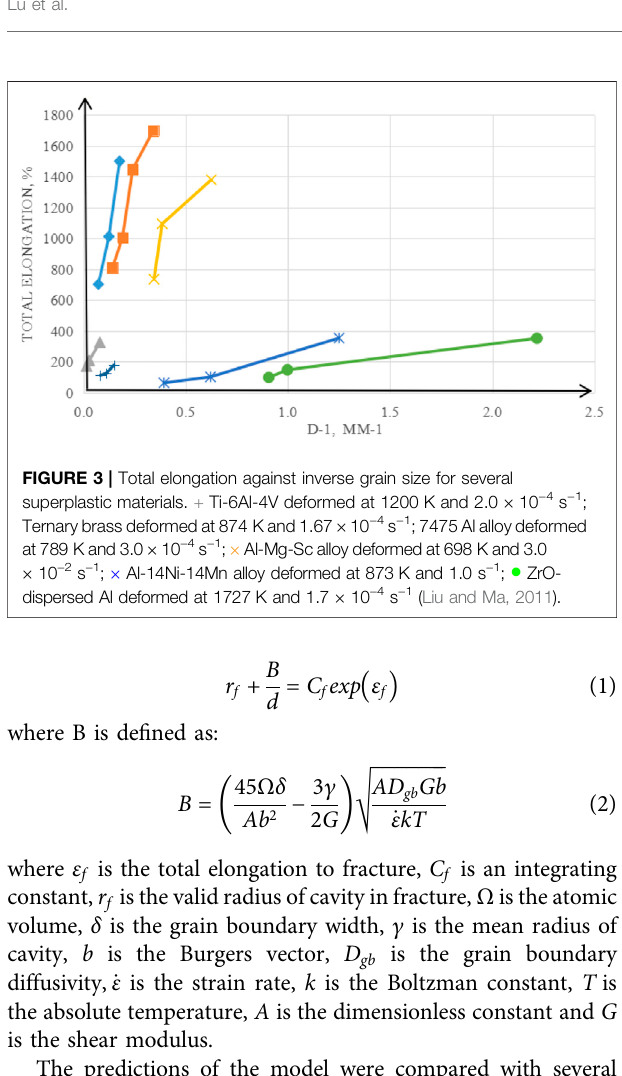
Frontiers in Materials |